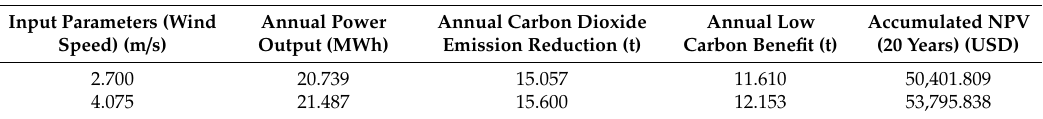
Table 16. The impact of wind speed on the environmental and economic profitability variables in this